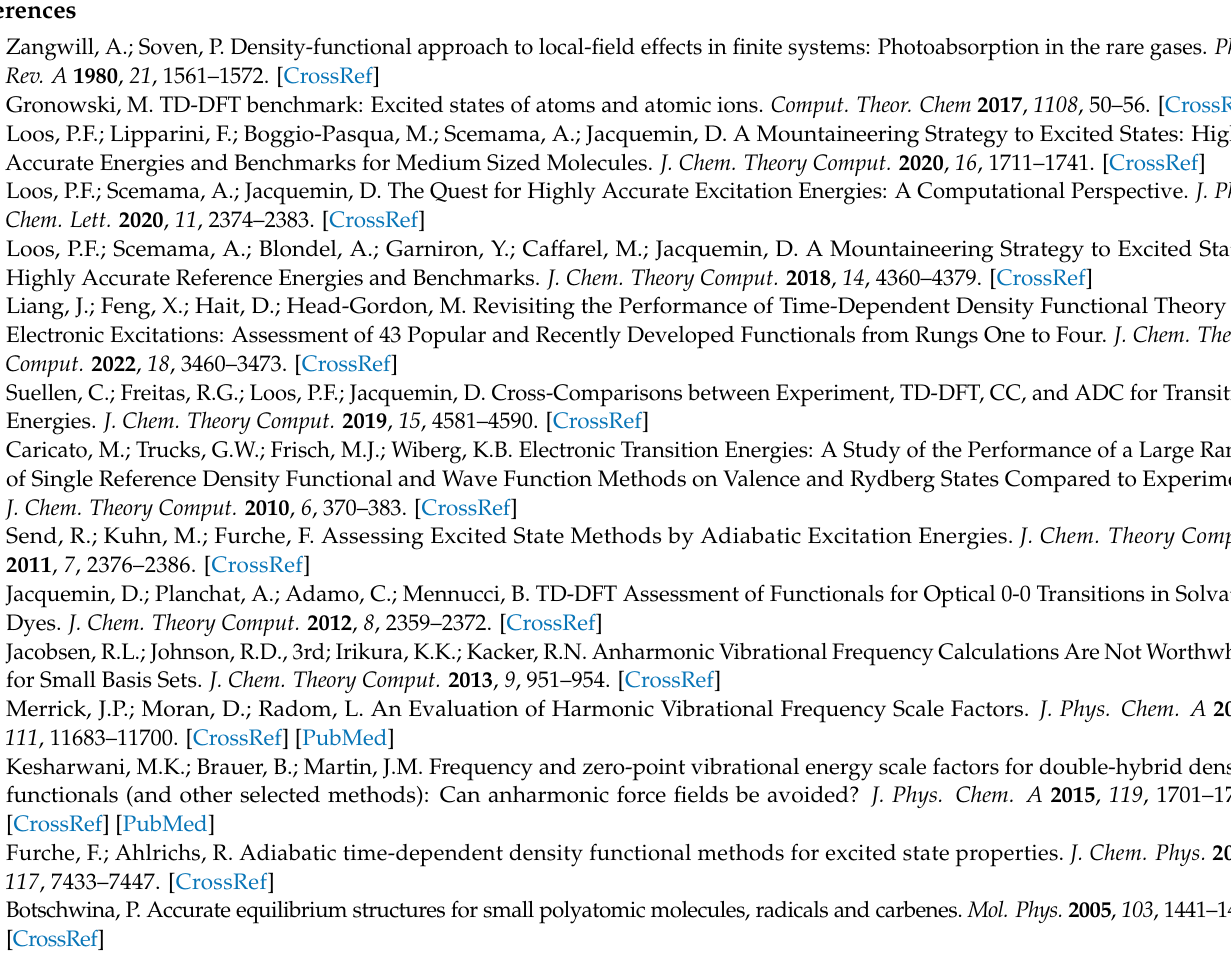
tended version of Figure 7; Figure S3: Extended version of Figure 8; Table S1: Full version of Table 1; Table S2: Full version of Table 2; Table S3: Full version of Table 3; Tables S4–S85: Electronic excitation energies predicted by various combinations of basis sets and functionals; Tables S86–S115: Harmonic vibrational frequencies predicted by various combinations of basis sets and functionals (shorter molecules); Tables S116–S119: Harmonic vibrational frequency scaling factors; Tables S120–S171: Harmonic vibrational frequencies predicted by various combinations of basis sets and functionals (longer